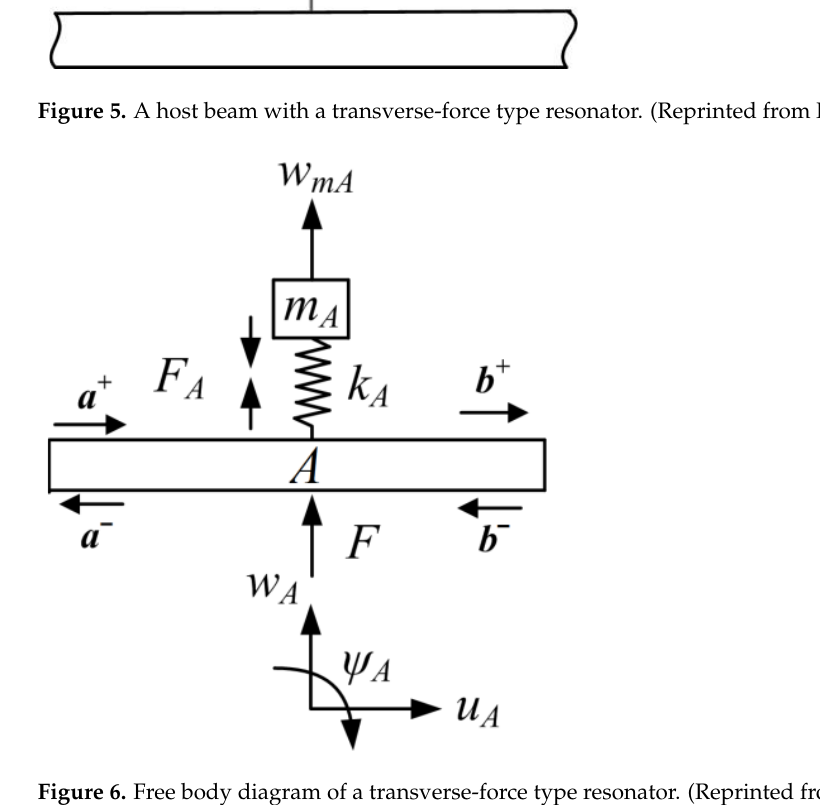
Figure 6. Free body diagram of a transverse-force type resonator. (Reprinted from Ref. [34].). According to Figure 6, the motion expression of the resonator is: